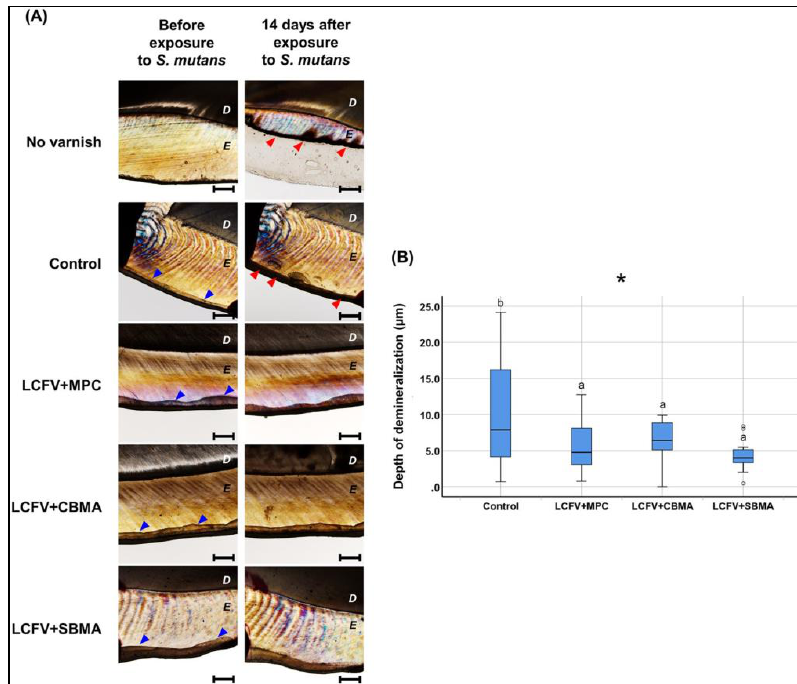
Figure 6. Protective action against demineralization of different polybetaine ZP additions into the fluoride varnish. ( A ) Polarized light microscopic examination and ( B ) the corresponding comparison of the depth of demineralization. Difference in the lower case letters indicate a significant difference between the groups. * p < 0.05 [55]. Int. J. Mol. Sci. 2020 , 21 , x FOR PEER REVIEW